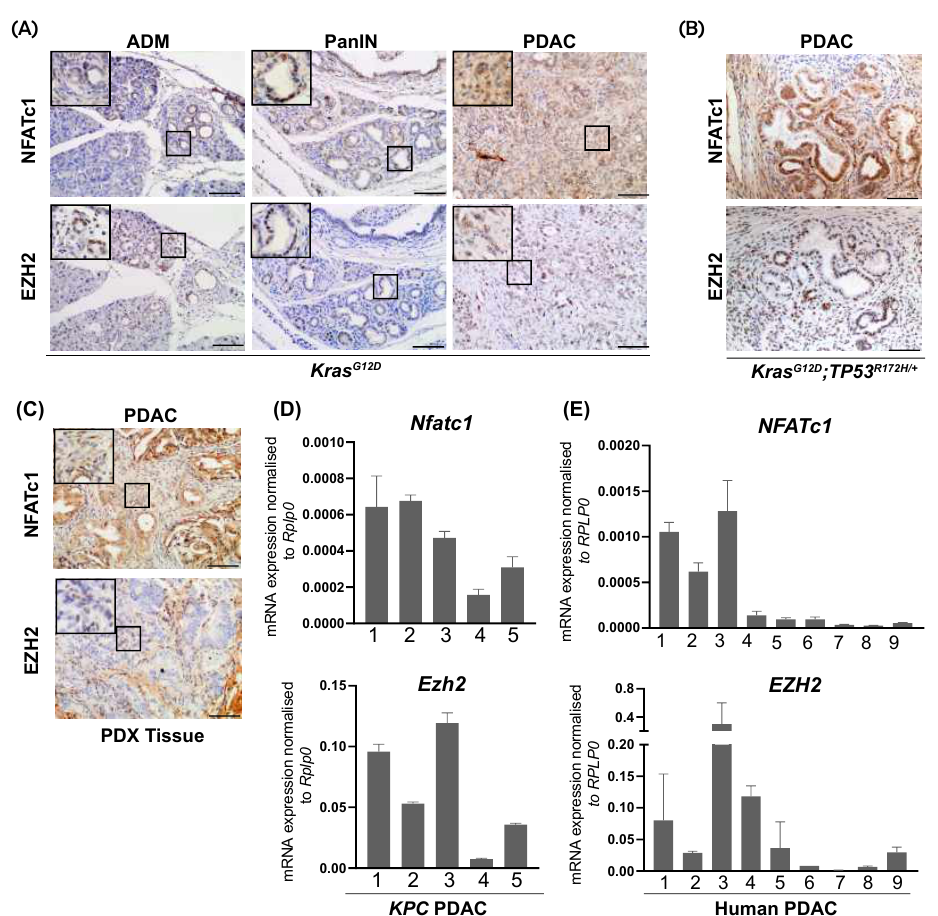
Figure 1. NFATc1 and EZH2 are co-expressed in a subset of murine and human PDAC samples. ( A ) Representative immunohistochemical analysis of NFATc1 and EZH2 in acinar cells, and pre- neoplastic lesions (ADM and PanIN, 6 mice each) and invasive PDAC in Kras G12D mice ( n = 6 mice). Magnification 20 × ; Scale bar: 50 µ m. ( B ) Representative immunohistochemical analysis of NFATc1 and EZH2 in PDAC of KPC mice ( n = 6). Magnification 20 × ; Scale bar: 50 µ m. ( C ) Representative immunohistochemical analysis of NFATc1 and EZH2 in a PDAC Patient-Derived Xenograft (PDX) model. Magnification 20 × ; Scale bar: 50 µ m. ( D , E ) NFATc1 - and EZH2 - mRNA expression in KPC ( D ) and human PDAC ( E ) upon micro-dissection of tumor cells. Every bar represents one mouse ( D ) or patient ( E ). ADM: Acinar to Ductal Metaplasia, PanIN: Pancreatic Intraepithelial